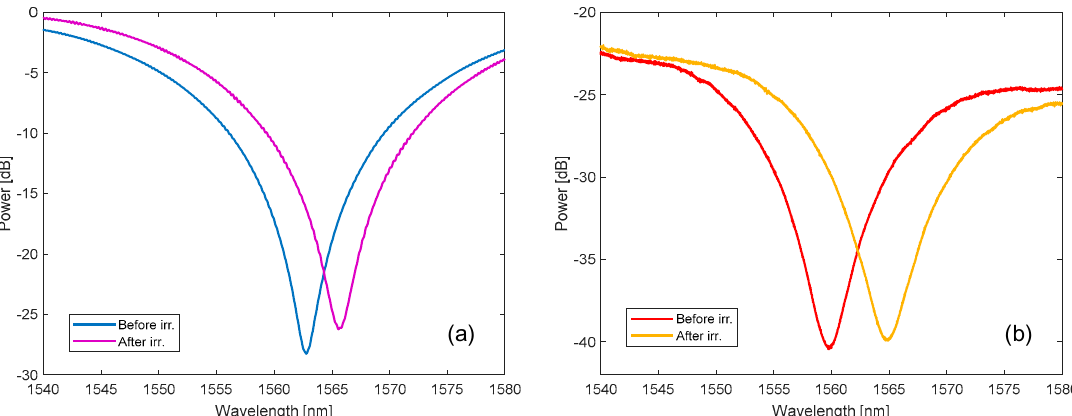
Figure 6. Comparison of the spectra of the LPGs before and after the irradiation performed using the: ( a ) Industrial irradiator SVST Co-60; ( b ) Novel proposed setup based on GC-5000.